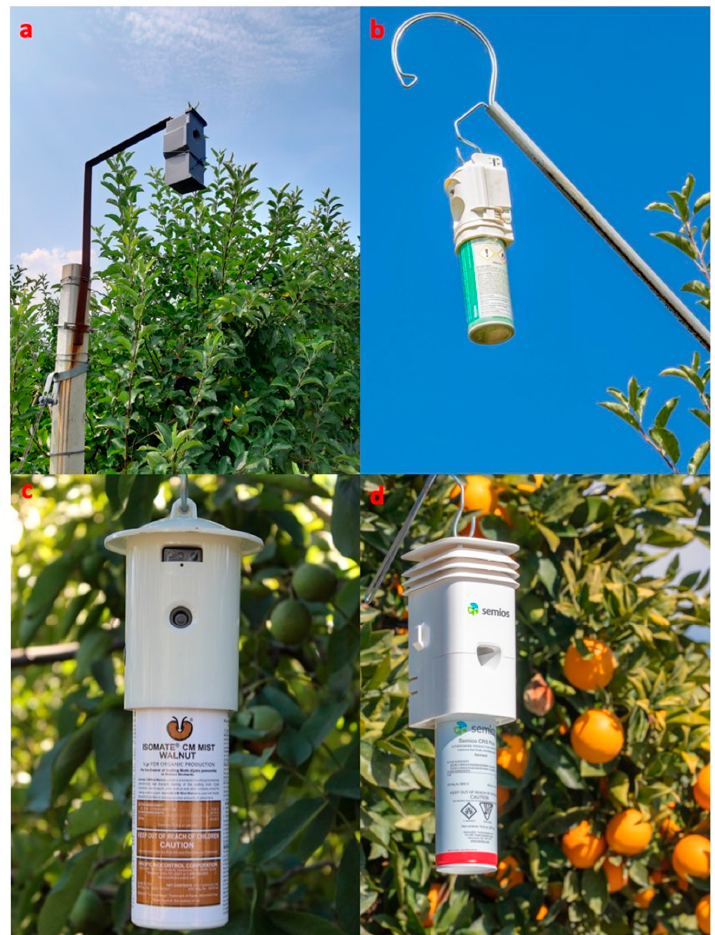
Figure 1. Examples of aerosol devices currently marketed (2018) for pheromone-mediated mating disruption of the codling moth, Cydia pomonella , in apple orchards, (a) CHECKMATE Puffer® CM (Suterra), (b) ISOMATE® CM MISTER (CBC Europe Srl-Italy) (photo credit: Claudio Ioriatti), (c) and in walnut orchards, ISOMATE® CM MIST WALNUT (photo credit: Tina Phelps). (d) Management of Aonidiella aurantii in orange groves relying to Semios CRS Plus (Semios Technologies Inc. Canada) (photo credit: Kelly Petersen).